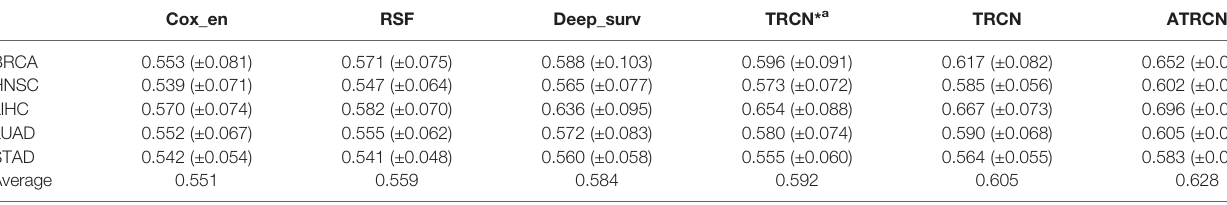
TABLE 2 | Prediction performance obtained in the different cancer